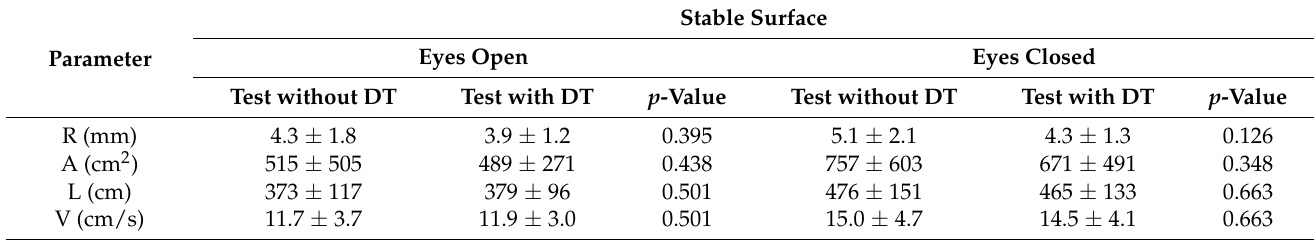
Table 1. Results of balance parameters before and after the application of dynamic tape for eyes open and eyes closed on a stable surface.